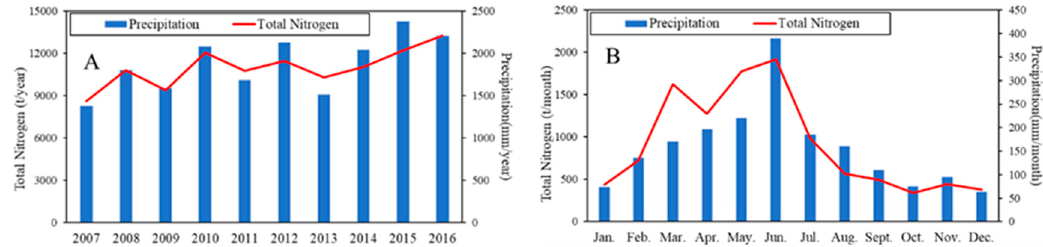
Figure 4. Annual ( A ) and monthly ( B ) variations in precipitation and TN output from the QLB during the interval from 2007 to 2016. Precipitation values were averaged from measurements at 54 sites across the basin, and TN output was measured at the basin’s outlet at Baqian.